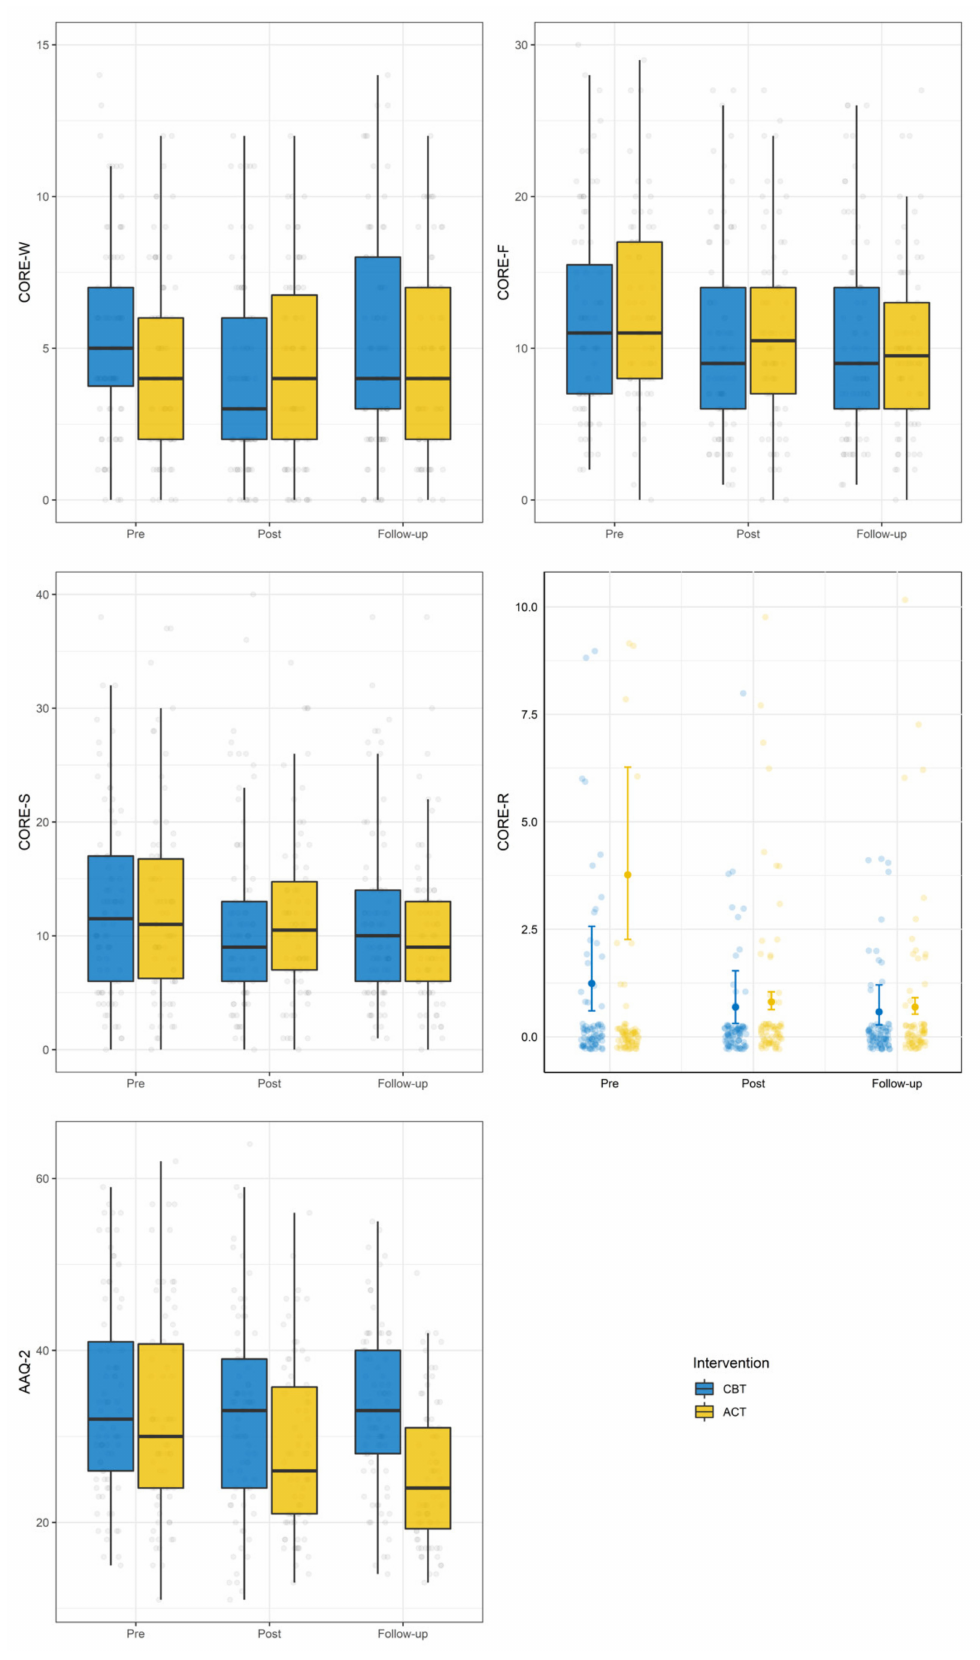
Figure 4. Changes over time of CORE-OM subscales and